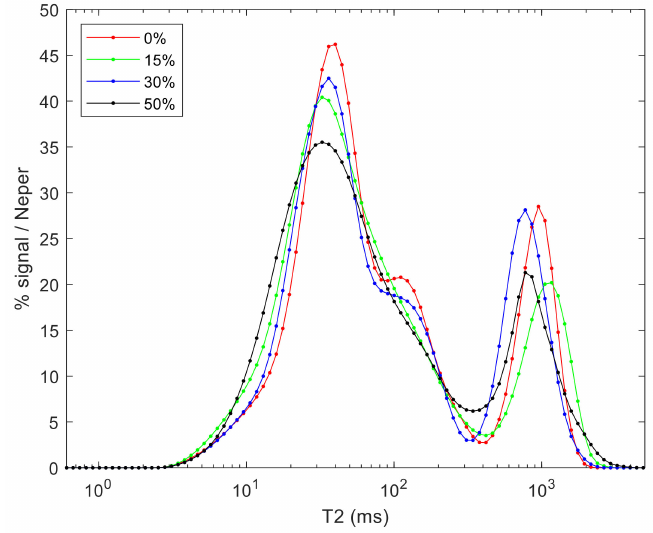
Figure 1. Mean T2 distribution of day 2 samples as function of frozen curd (FC) content. Different FC concentrations are denoted by solid coloured